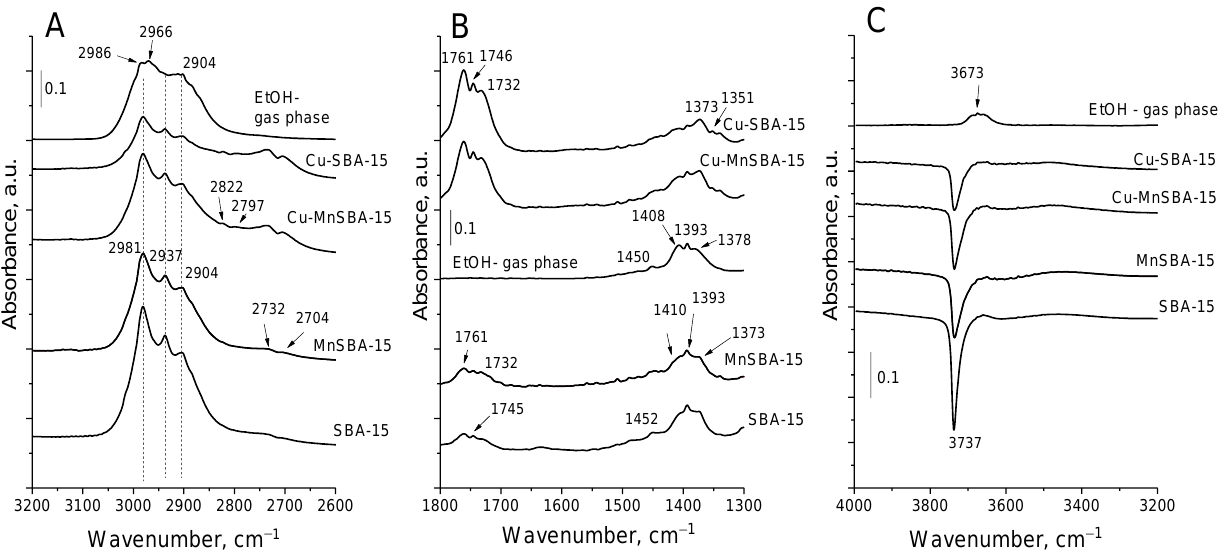
Figure 5. FTIR spectra recorded in ethanol flow at 593 K after 45 min of the dehydrogenation reaction for SBA-15, MnSBA-15, Cu-SBA-15, and Cu-MnSBA-15 materials: ( A ) 3200–2600 cm − 1 range; ( B ) 1800–1300 cm − 1 range; ( C ) 4000–3200 cm − 1